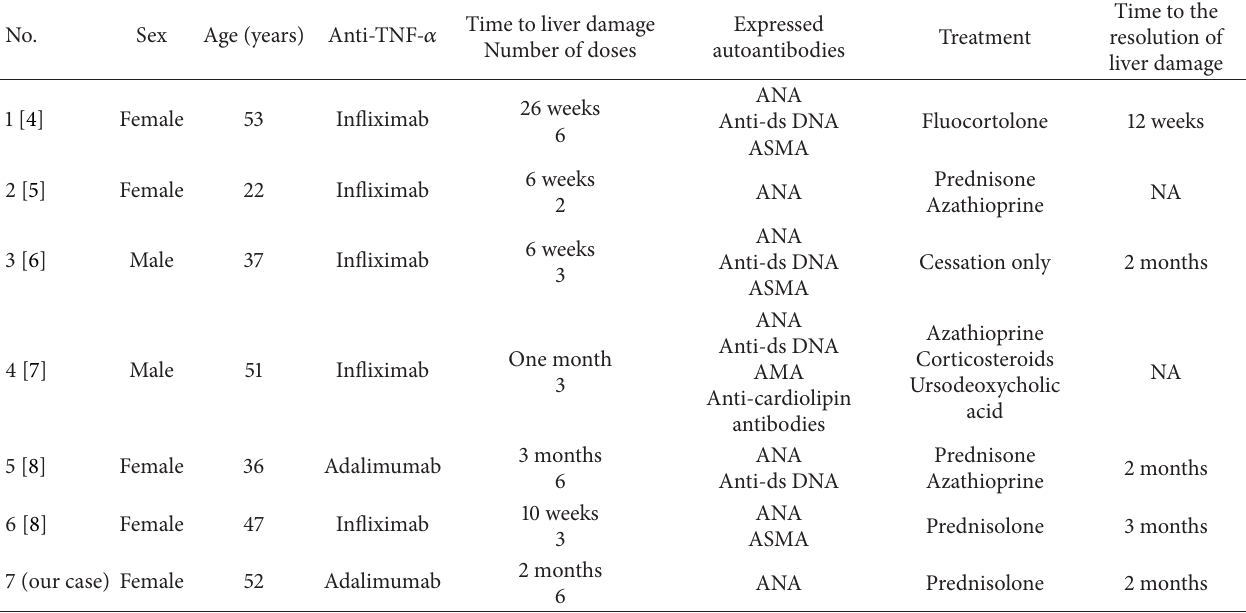
Table 1: Reported cases of psoriasis with AIH triggered by anti-TNF- 𝛼 therapy.